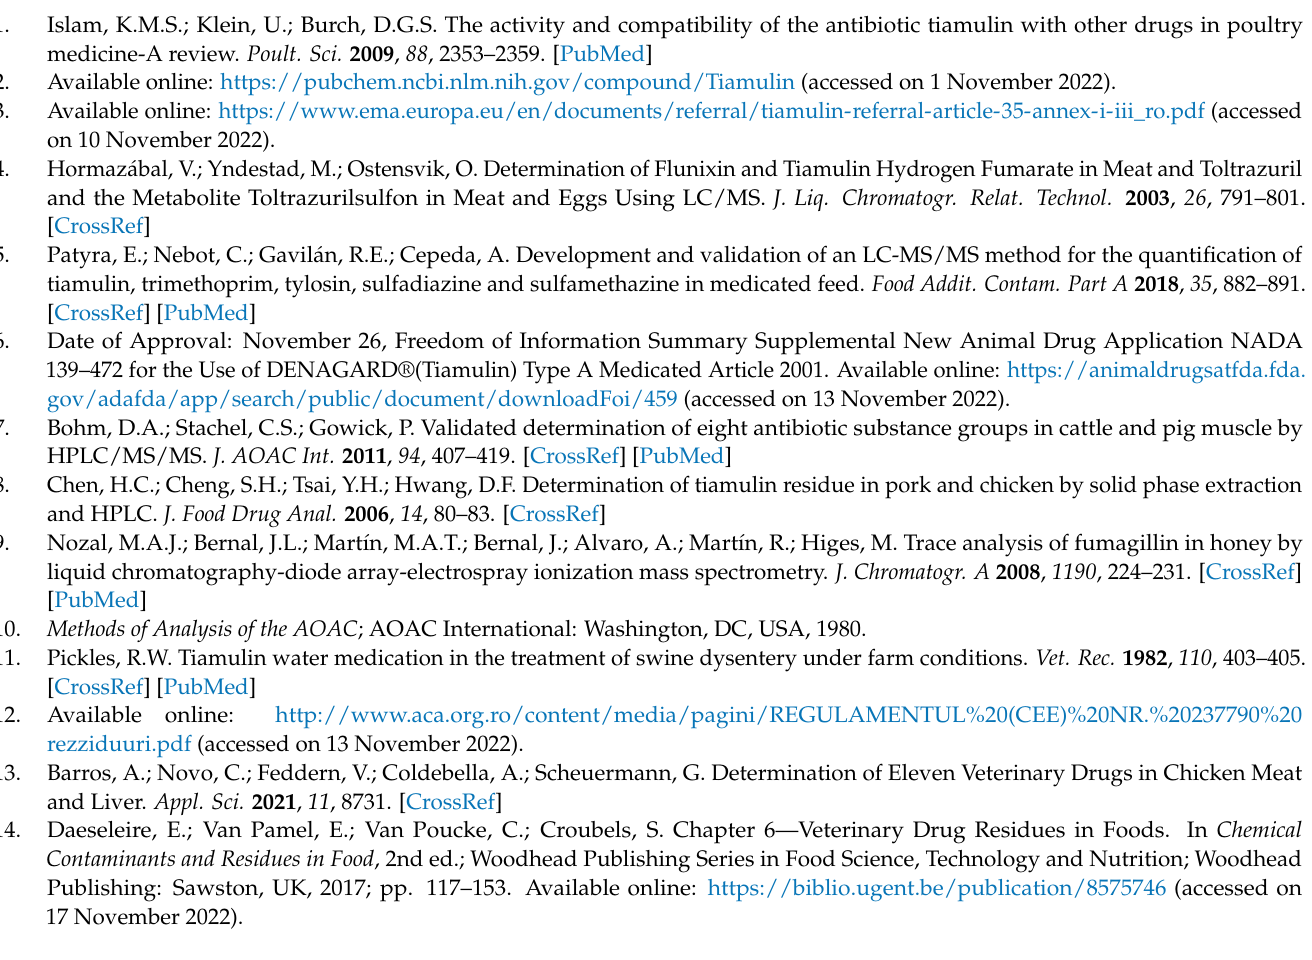
Figure A5. Calibration curve for tiamulin (0.05–1 μ g/kg).